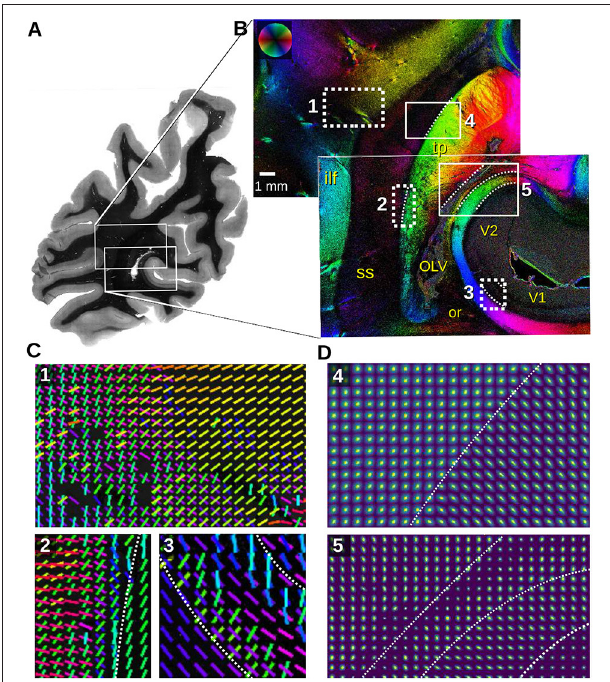
FIGURE 8 | Section of a left human hemisphere measured with angular/scatterometry SLI. (A) Transmittance image. (B) In-plane fiber orientations obtained from an angular SLI measurement with 1φ = 5 ◦ steps/width, θ = [42.5,47.5] ◦ , px = 3 µ m, performed 8 months after tissue embedding with green light (gain factor 2, illumination 3 s). Relevant anatomical structures are labeled in yellow (ilf, inferior longitudinal fascicle; OLV, occipital lateral ventricle; or, optic radiation; ss, sagittal stratum; tp, tapetum; V1, primary visual cortex; V2, prestriate visual cortex). (C) Fiber orientation vectors are shown for every 40 th image pixel for the regions (1,2,3) marked in (B) . Vectors are shown if at least 8% of the surrounding 40 × 40 pixels have a defined fiber orientation. (D) Scattering pattern maps obtained from SLI scatterometry measurements of the same sample (4 × 4 illuminated LEDs, 64 × 64 kernels, gain factor 10, illumination 3 s, 8 months after tissue embedding), shown for every 50 th image pixel for the regions (4,5) marked in (B) . The white dashed lines indicate tissue borders for better